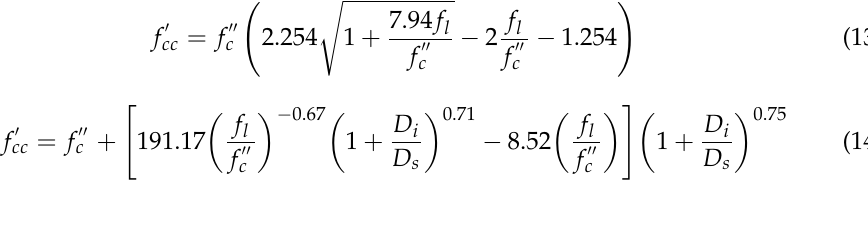
(16) where, in Equation (15), E FRP (MPa) = tensile elasticity modulus of FRP wraps; t FRP (mm) = thickness of all FRP wrapping layers; in Equation (16), the modifications are represented as follows: The total fiber sheets ( t FRP ) was replaced by the spiral diameter dh (mm). The diameter of a circular section wrapped with FRP ( D ) was replaced with the diameter of the effectively confined concrete core ( D s − D i ) (mm). Finally, the E FRP × ε h , rup (the tensile strength of the FRP wraps) was considered to account for the significantly reduced tensile capacity of the GFRP spirals at the bent portion when the straight FRP bar is bent to form